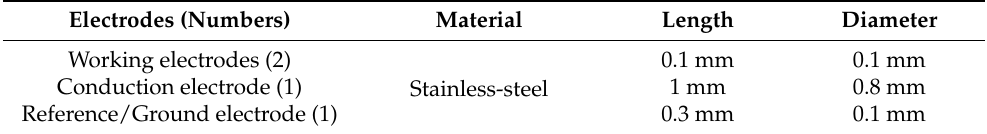
Table 1. Technical data for the neural